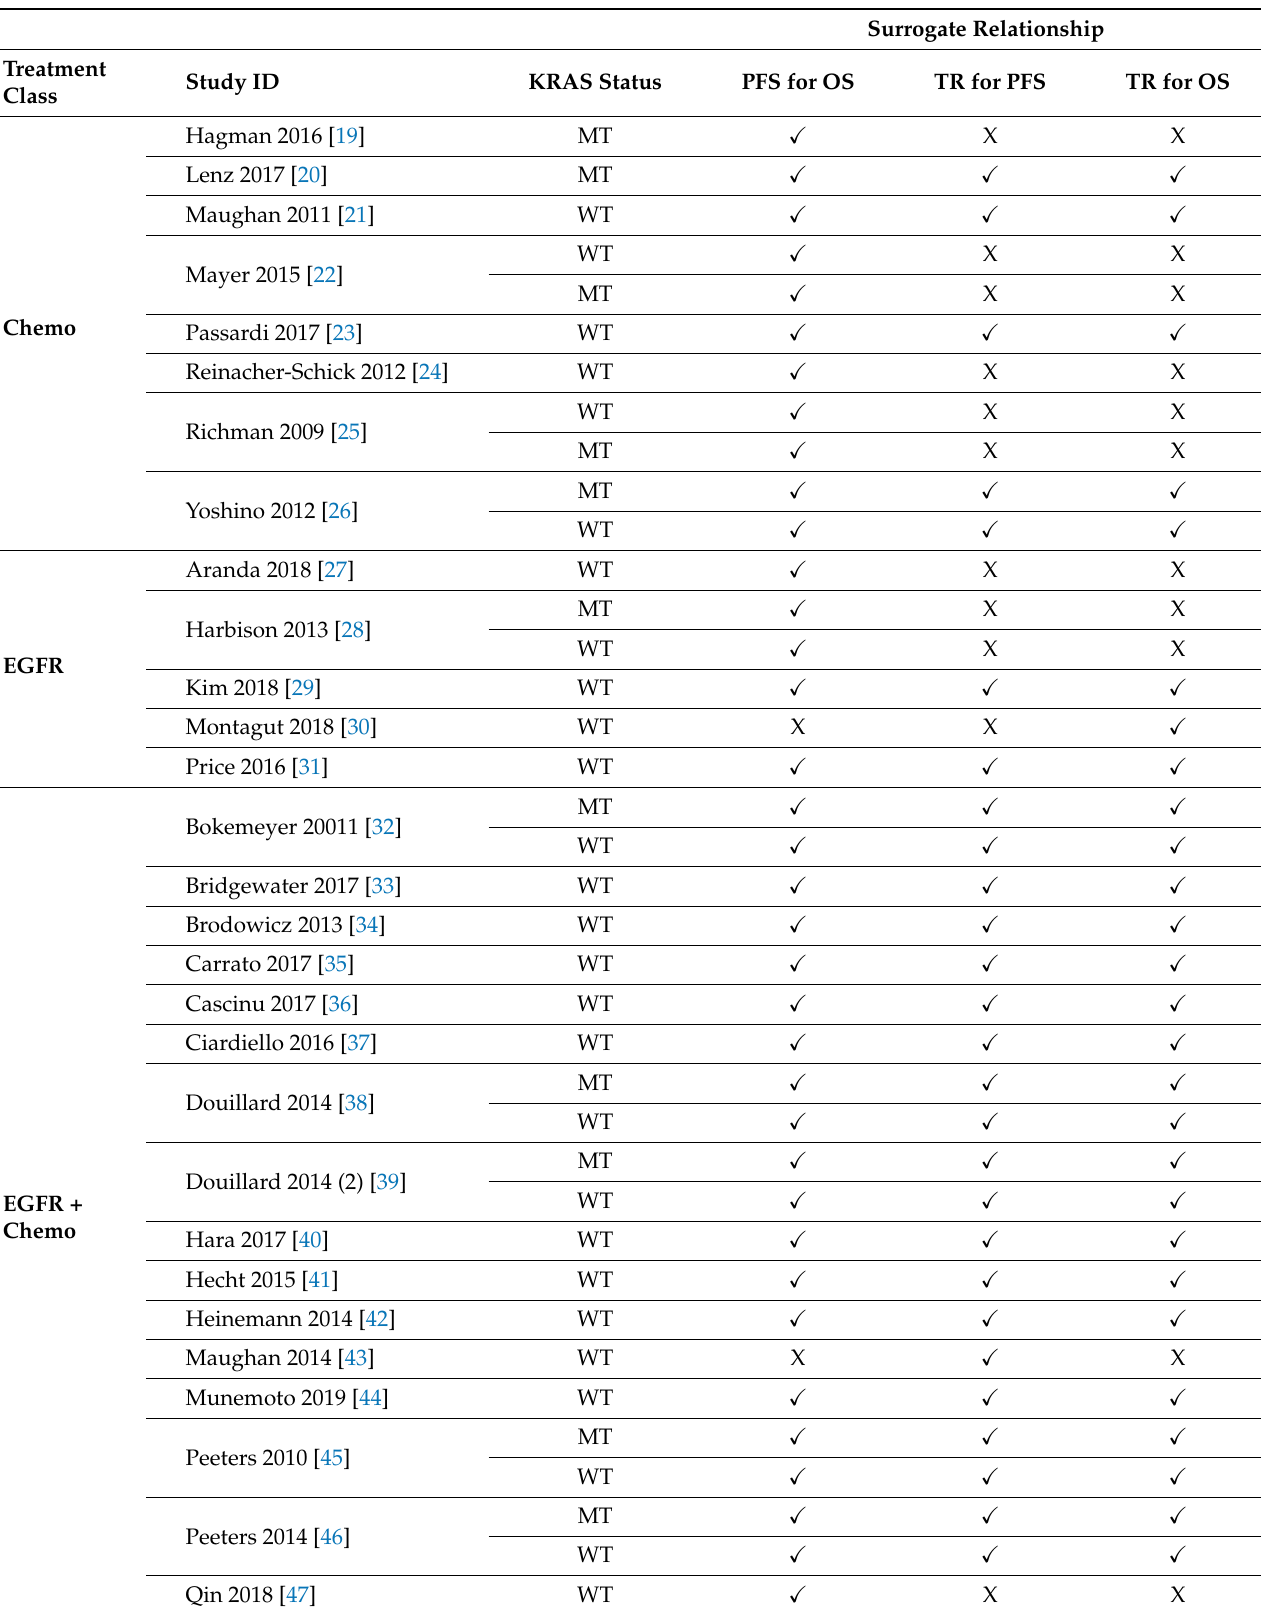
Table 2. Full list of trials included for each